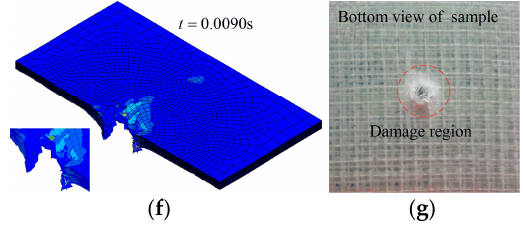
Figure 5. The simulation results on the composite laminates at different times, group A2: ( a ) t = 0.0015 s; ( b ) t = 0.0030 s; ( c ) t = 0.0045 s; ( d ) t = 0.0060 s; ( e ) t = 0.0075 s; ( f ) t = 0.0090 s; ( g ) bottom view of sample.